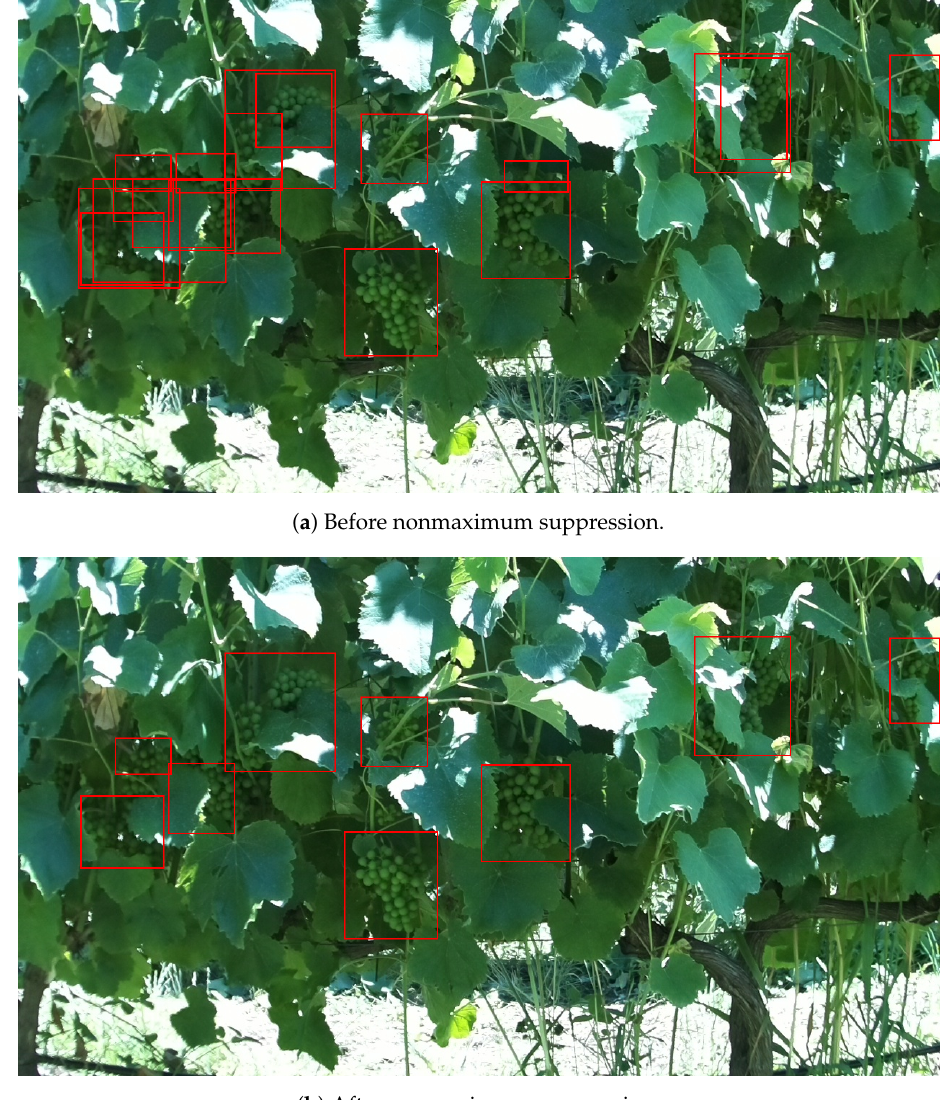
Figure 7. Impact of nonmaximum suppression on the final inference